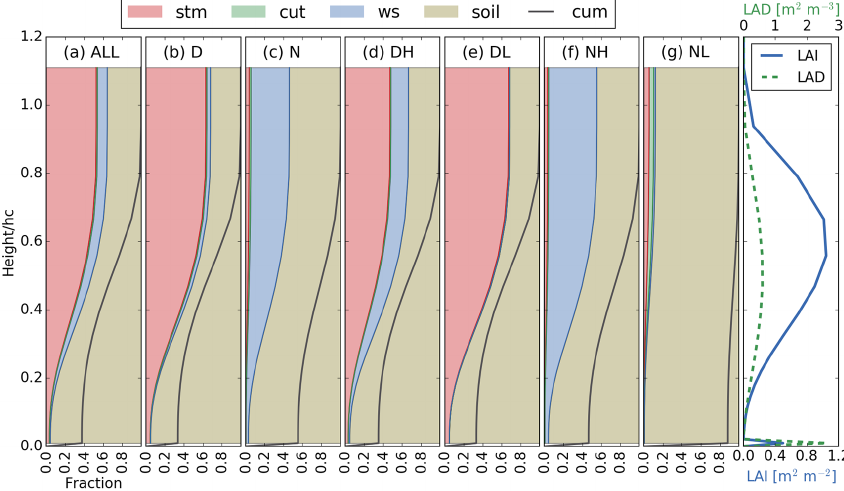
Figure 9. Simulated vertical profiles of cumulative O 3 deposition flux normalised by the integrated O 3 deposition flux above the canopy (cum, solid black line) for four conditions: DH (a) , DL (b) , NH (c) and NL (d) . D and N represent daytime and nighttime and H and L represent high and low humidity, respectively. Shaded areas are the cumulative contribution fractions for different deposition pathways, including stomatal uptake (stm, red), cuticle uptake (cut, green), wet skin uptake (ws, blue) and soil uptake (soil, pale brown). The all-sided LAI profile for each layer and LAD is plotted again here (e) . The height is normalised by the canopy height h c